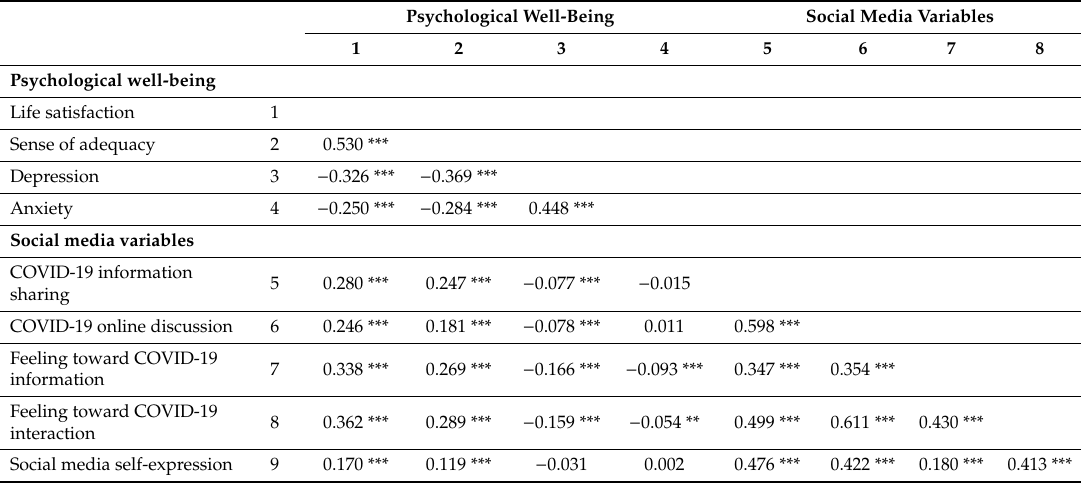
Table 1. Correlations between psychological well-being and social media variables.